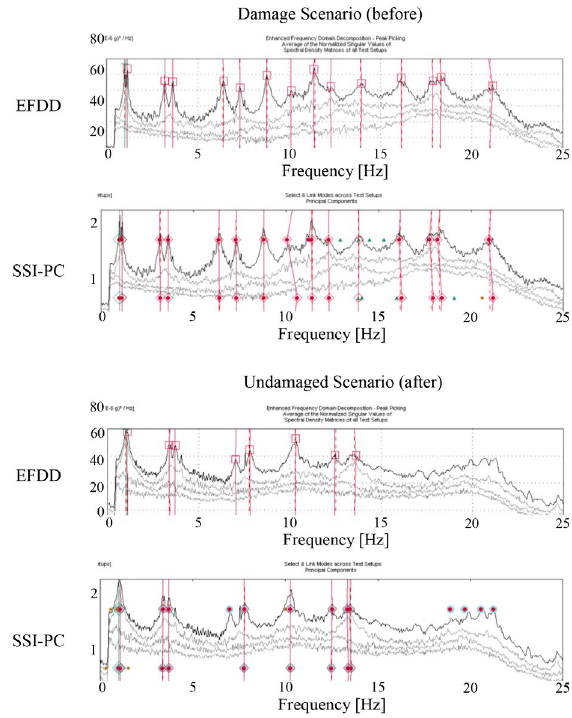
Figure 5. Modal features estimation before and after works: En- hanced Frequency Domain Decomposition vs Stochastic Subspace Identification.